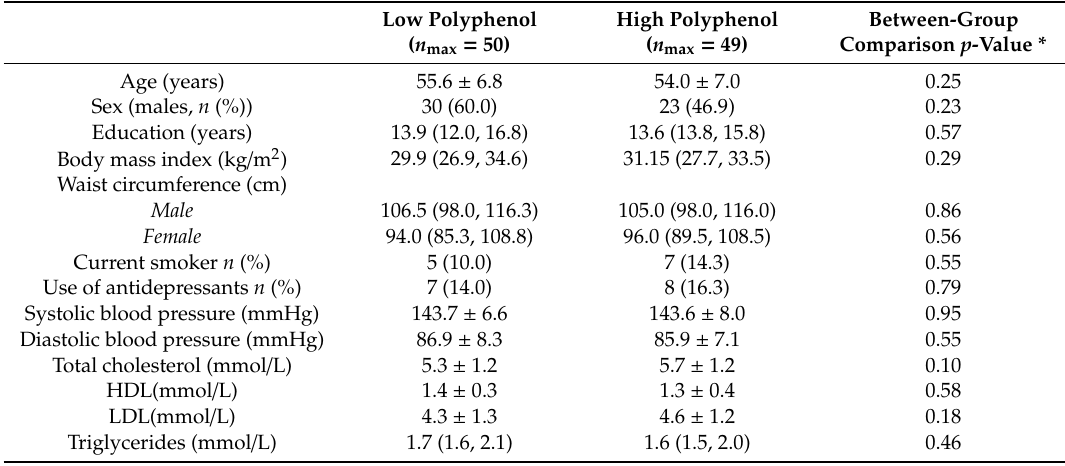
Table 1. Baseline (week 0) participant characteristics according to the Polyphenol Intervention Trial (PPhIT) study group